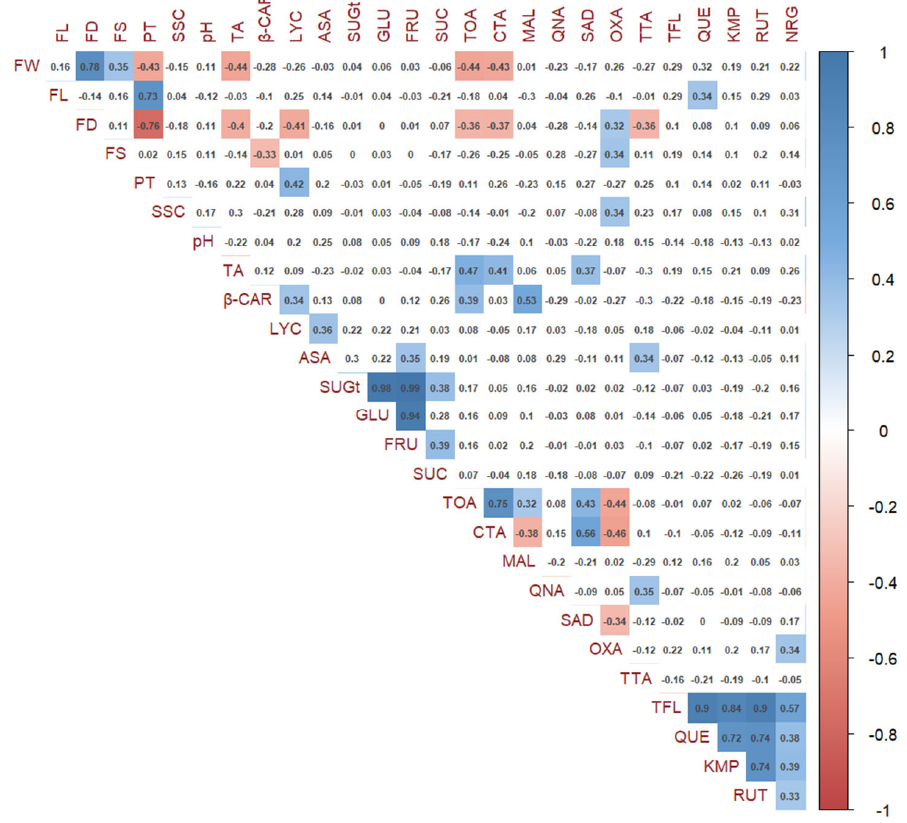
Figure 5 . Pearson’s rank correlation coefficients between agronomic, chemical and biochemical traits. The correlation coefficients are indicated in each cell. Coloured correlations are those with p ‐ values < 0.01. The colour intensity is directly proportional to the coefficients. On the right side of the correlogram, the colour legend shows the correlation coefficients and the corresponding colours.